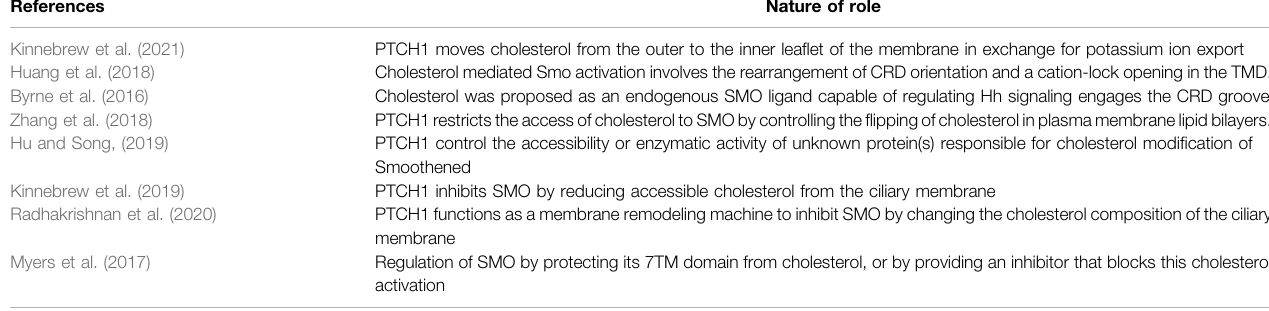
TABLE 2 | Summary of cholesterol functions in PTCH1 and